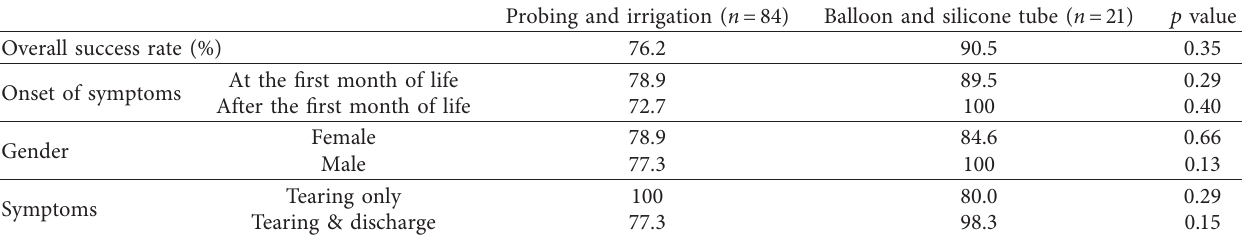
Table 3: Effect of patient-related factors on surgery success rates (%) between patients with probing and irrigation and those with balloon catheter dilation and silicone